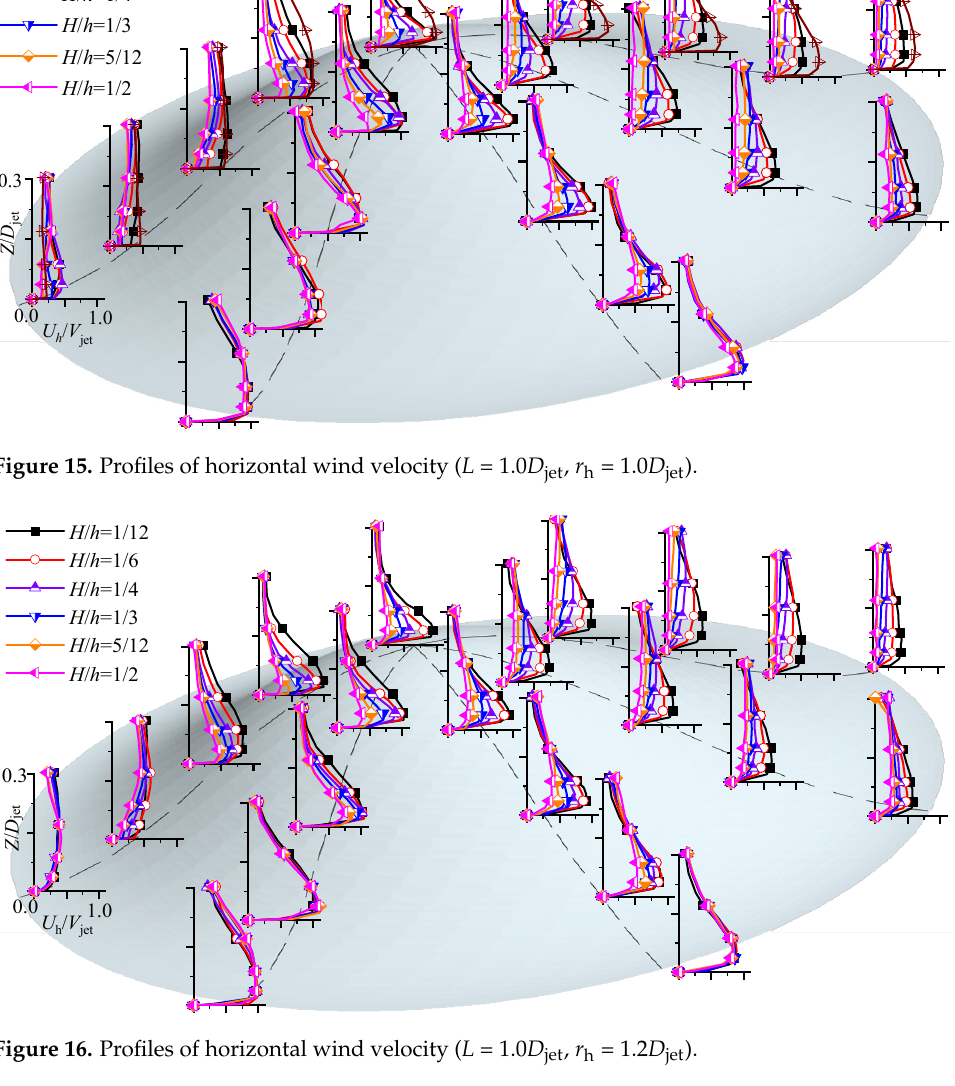
Figure 16. Profiles of horizontal wind velocity ( L = 1.0 D jet , r h = 1.2 D jet ).